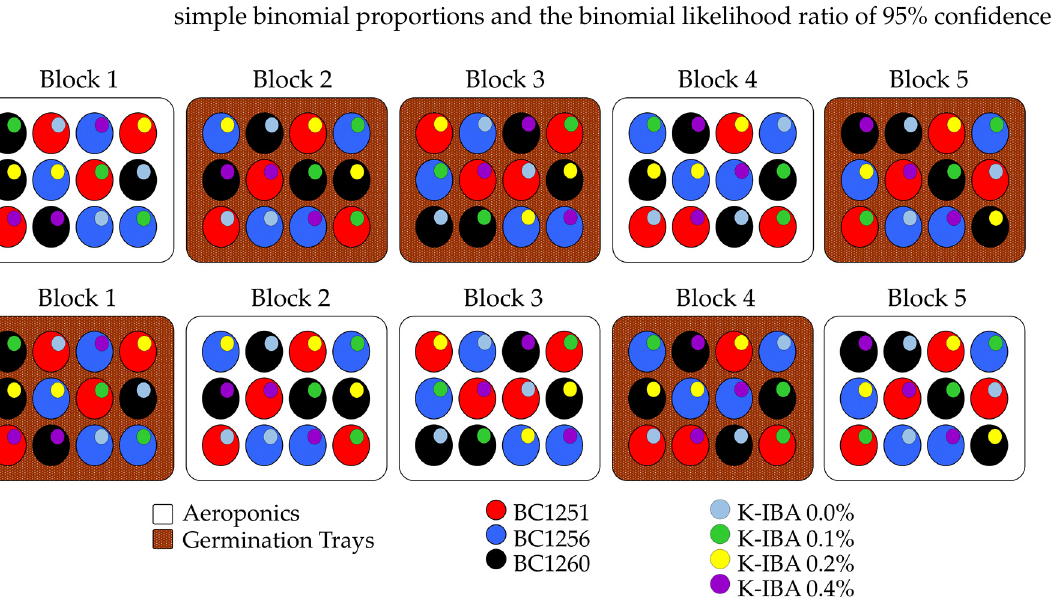
Figure 9. Scheme of the experiment setting under a split-plot experimental design with five replications, under laboratory conditions.